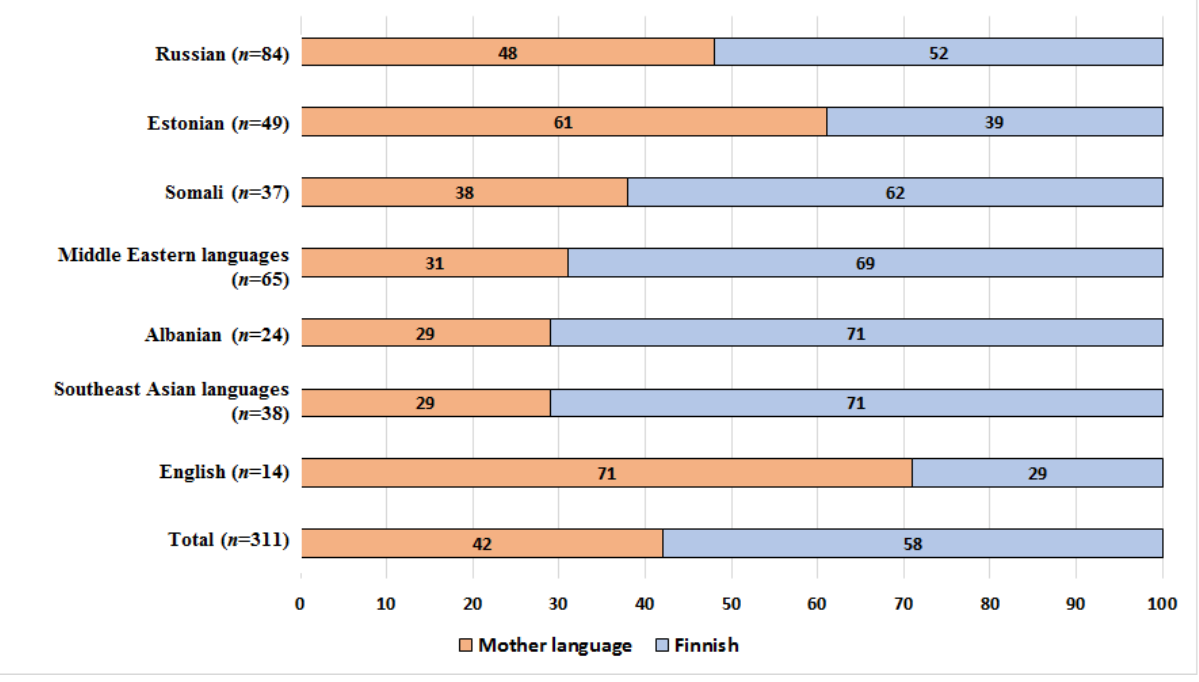
Figure 1. Response language (%) in multilingual Web survey by language